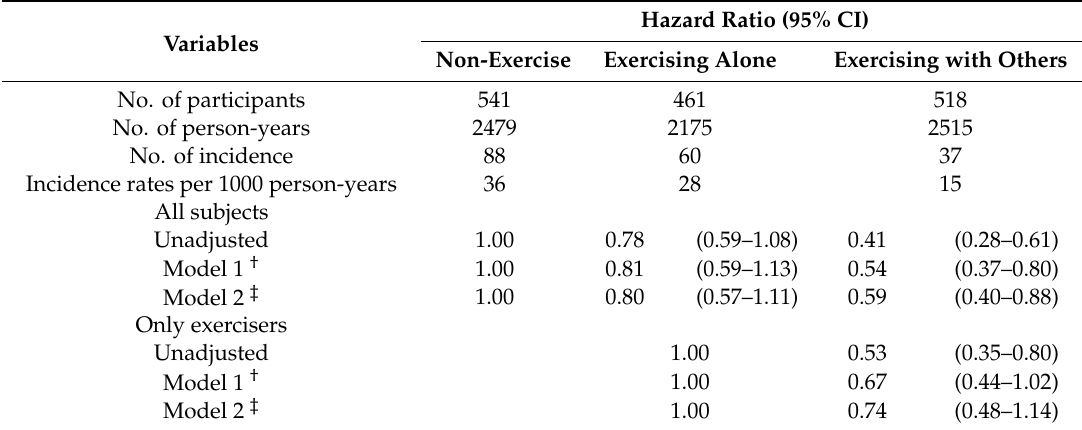
Table 2. Hazard ratios for the five-year incident functional disability according to exercise habits.